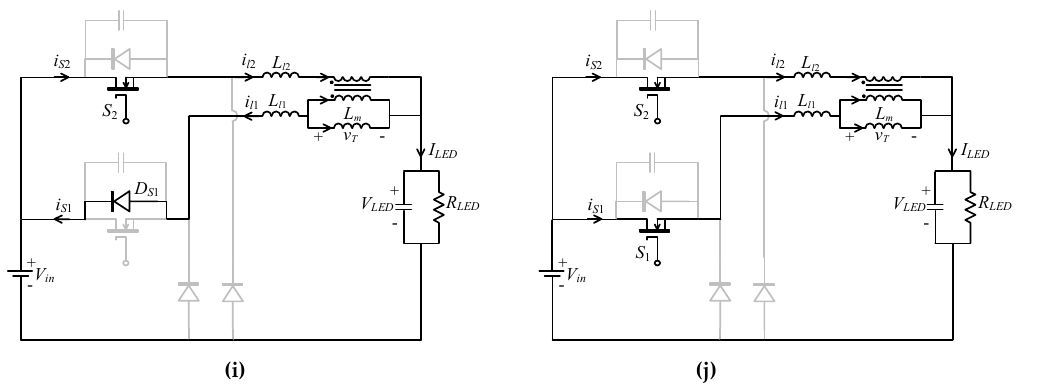
Figure 4. Equivalent circuits of different operating modes. ( a ) Mode I; ( b ) mode II; ( c ) mode III; ( d )